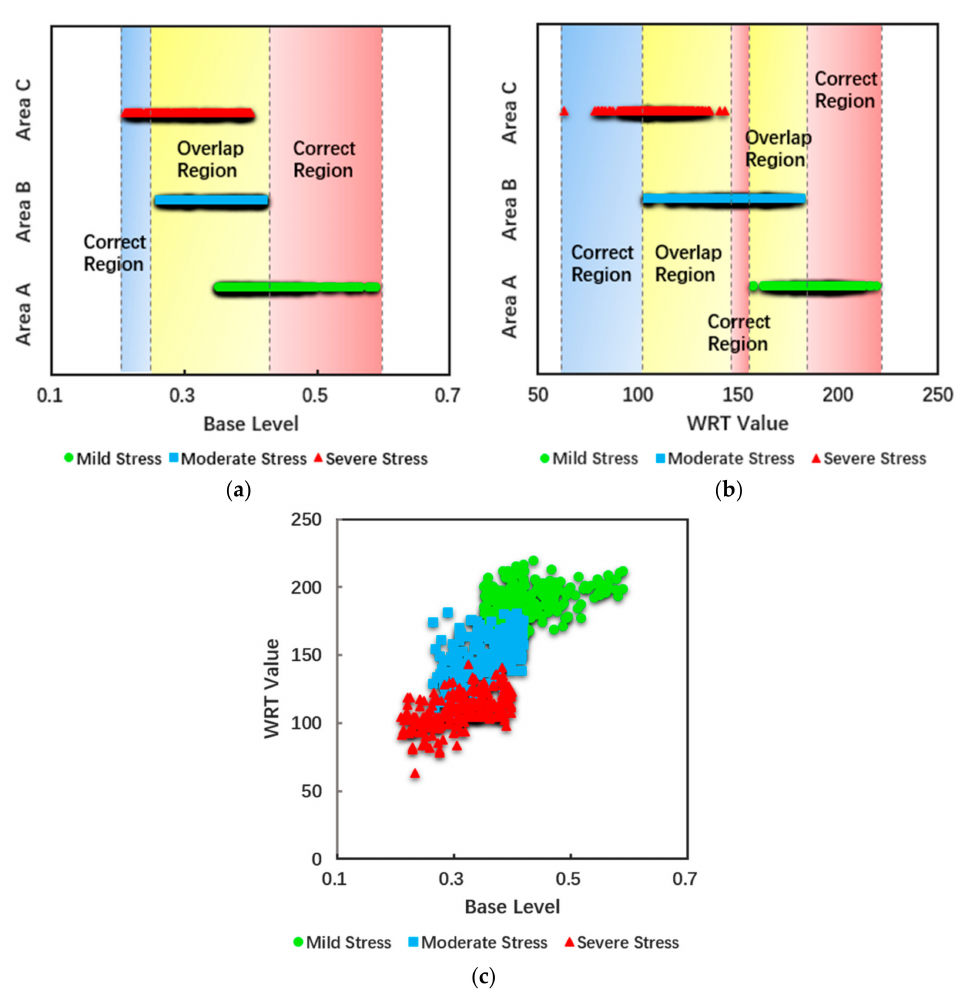
Figure 8. The one-dimensional judging space based on ( a ) a phenological indicator (base level) or ( b ) WRT, and ( c ) the two-dimensional judging space combining base level and